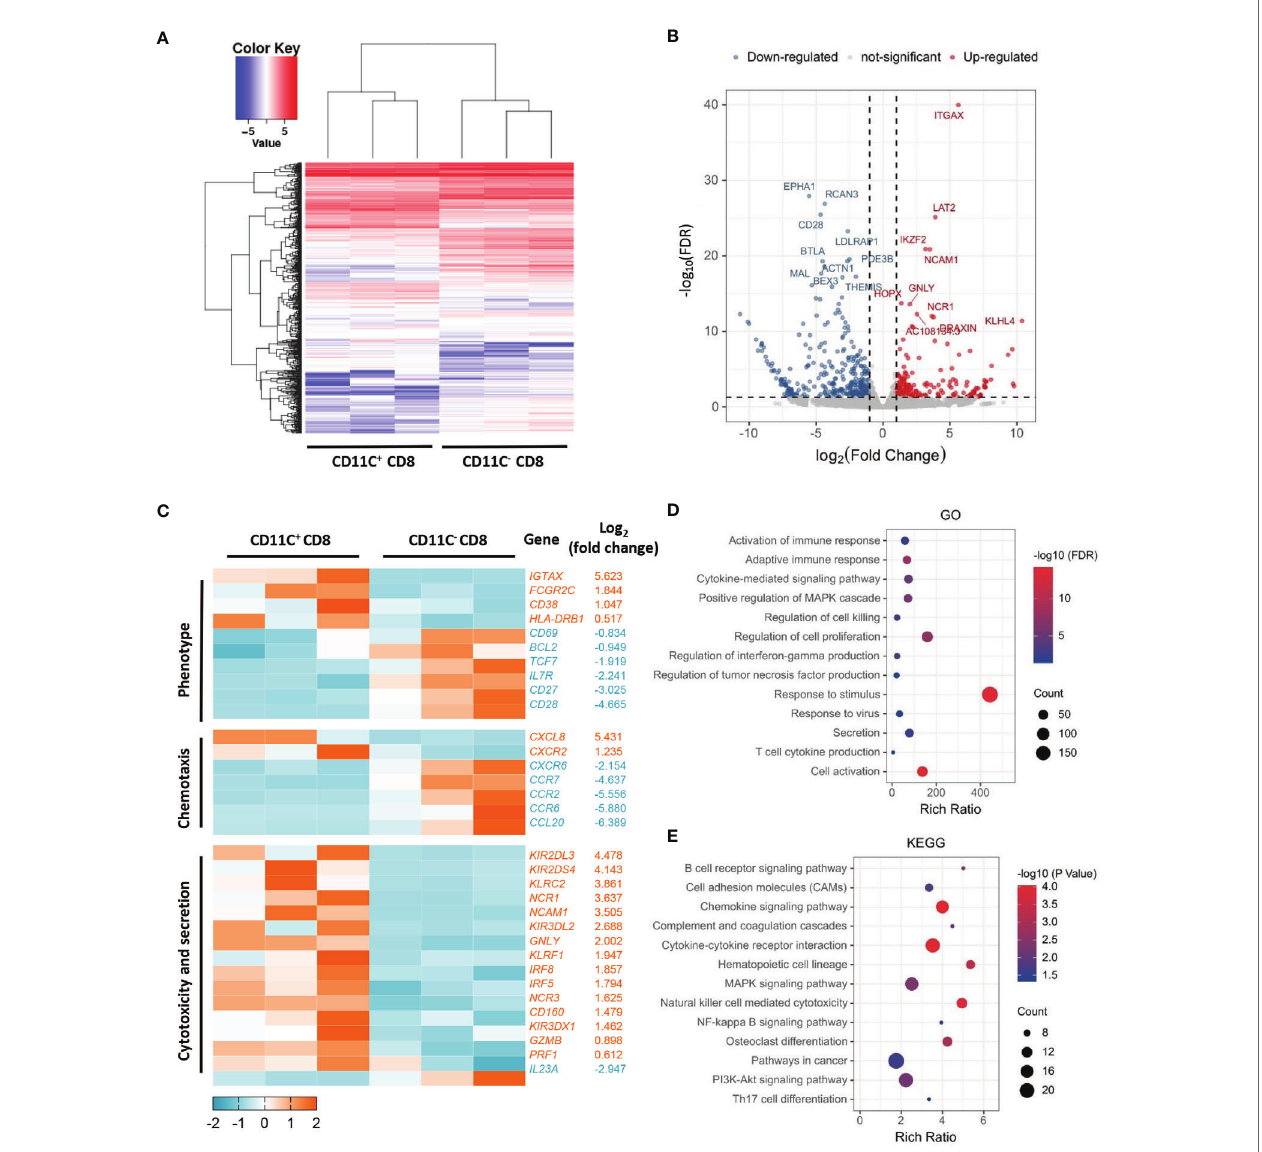
FIGURE 1 | Distinct transcriptome pro fi les of CD11c + and CD11C - CD8 + T cells. (A) Heatmap of transcriptomic pro fi ling of CD11c + and CD11c - cell subsets. (B) Volcano plot of differentially expressed genes. Rich ratio > 2, P < 0.05, FDR < 0.05 were considered signi fi cant. (C) Heatmap of representative genes with the log 2 (fold change). (D) GO and (E) KEGG enrichment analyses showing the signi fi cantly enriched ( P < 0.05)